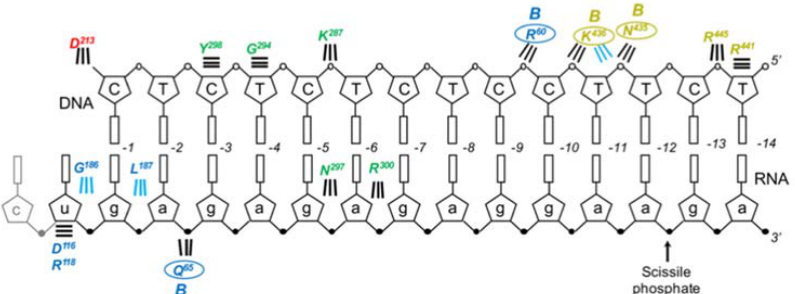
Figure 3. Contacts between Ty3 RT subunits A and B and the PPT ‐ containing RNA/DNA hybrid. Color coding is consistent with subdomain designation of Figure 2, and DNA and RNA nucleotides are denoted in capital and small letters, respectively. The scissile PPT/U3 junction has been indicated, and base numbering is relative to substrate bound at the DNA polymerase active site Subunit B contacts are denoted “B” and circled. Parallel horizontal lines indicate van der Waals interactions. Diagonal and vertical lines indicate interactions mediated by the protein backbone (cyan) or side chains (black).